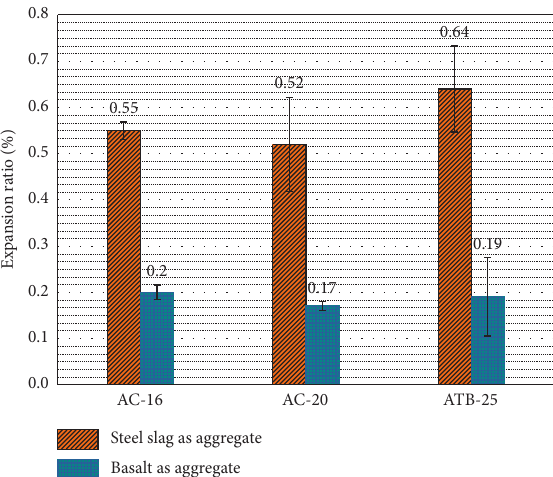
Figure 5: The volume expansion rate of asphalt mixture with steel slag.